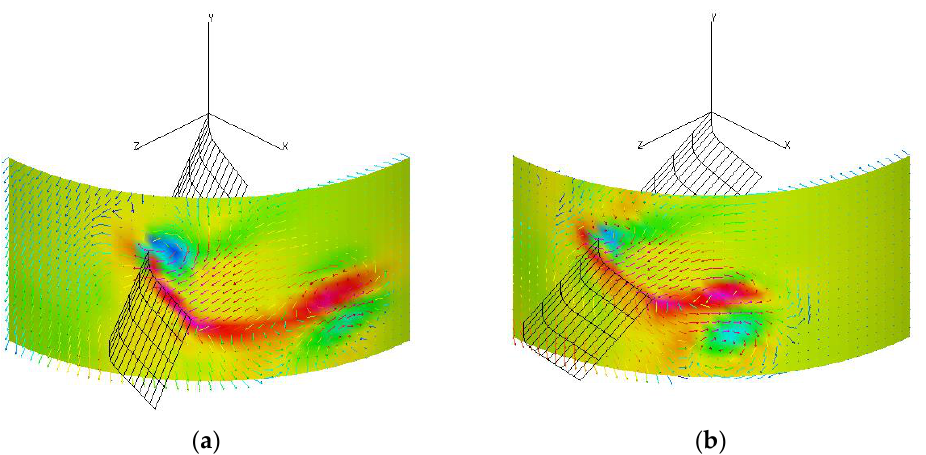
Figure 10. Flow fields on the cylindrical plane crossing the flapping wing at the time instant of 6.65 cycle when the nondimensional lift takes the first peak in the second half stroke: ( a ) Φ = 123°, F r = 5.1, α = 0.073; ( b ) Φ = 80°, F r = 3.3, α = 0.11. In each cylindrical plane, the color contour shows the magnitude of the vorticity in the wing’s longitudinal direction, the arrows show the fluid velocity field, and the color of each arrow shows the magnitude of the velocity.